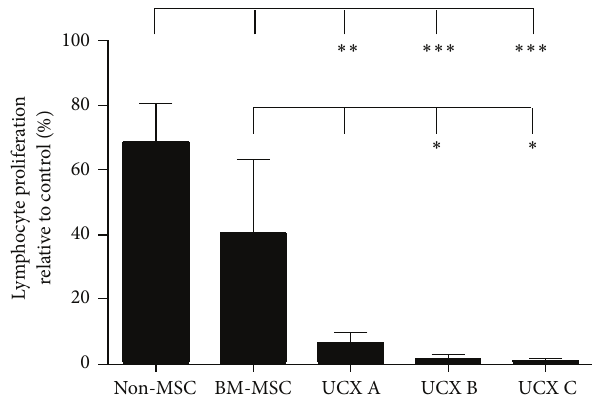
Figure 2: UCX are less immunogenic than BM-MSCs. PBMCs from two different donors were incubated with a non-MSC cell line (Molt4), BM-MSC, and UCX from 3 independent donors. Lymphocyte proliferation was measured as [ 3 H]thymidine uptake (ccpm). UCX, and to a lesser extent BM-MSC, failed to induce lymphocyte activation in an allogeneic MLR. Values are represented as mean ± s.e.m. and statistically significant differences are indicated by asterisks (one-way ANOVA with a Tukey posttest; ∗ 𝑃 < 0.05 , ∗∗ 𝑃 < 0.01 , and ∗∗∗ 𝑃 < 0.001 ).